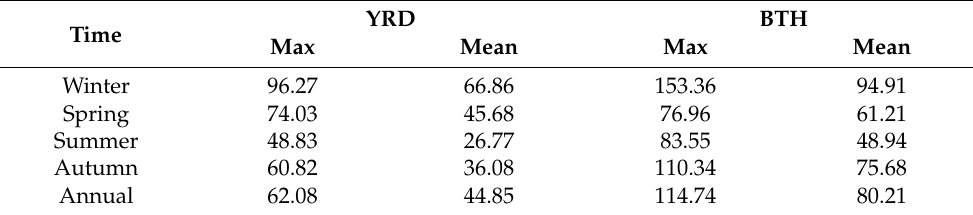
Table 6. Estimated seasonal and annual PM 2.5 concentrations in the YRD and BTH regions.